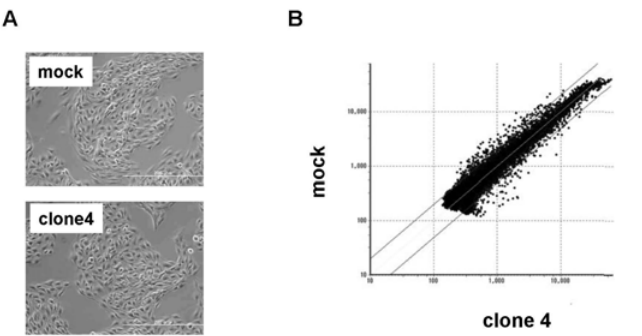
Figure 2. Scatter plot of mock vs. VASH1 over expression clone 4.